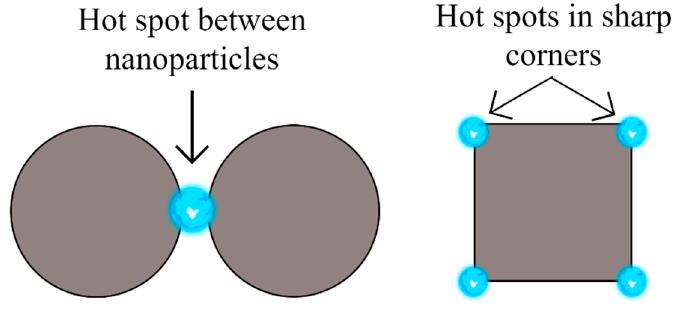
Figure 1. Location of hot spots.